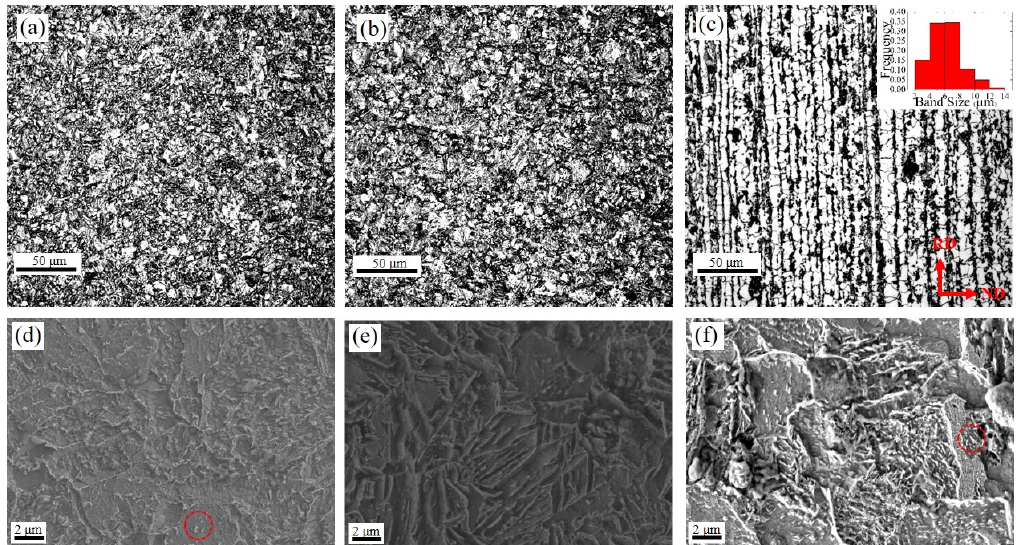
Figure 3. The initial starting microstructures obtained through different thermal processing routes: ( a ) the bainite microstructure obtained during isothermal holding at 500 °C for 30 min; ( b ) the martensite microstructure achieved through quenching down to 100 °C; ( c ) the ferrite + pearlite microstructures generated by isothermal holding at 700 °C for 30 min. The upper right inset in ( c ) is the distribution map of band width, while ( d – f ) are SEM images corresponding to the microstructure as shown in ( a – c ). The red circle marks the carbide precipitations.